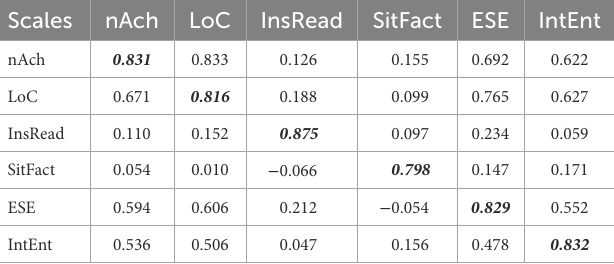
TABLE 6 Discriminant validity coefficients (fornell-larcker criterion) and heterotrait-monotrait (HTMT) ratios.